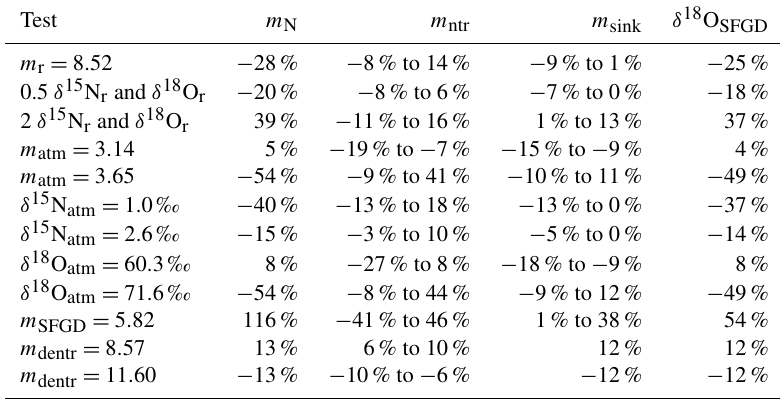
Table 2. Results of sensitivity tests on mass fluxes and